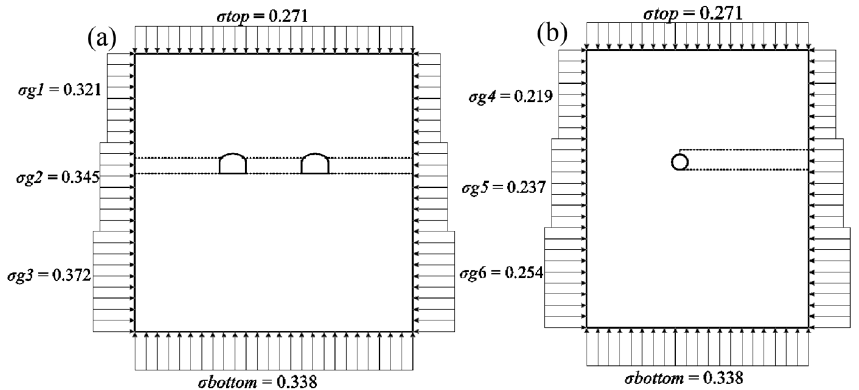
Figure 10. Schematic diagram of non-uniform gradient distribution of initial ground stress of the model. ( a ) Direction of large principal stress and ( b ) direction of small principal stress.